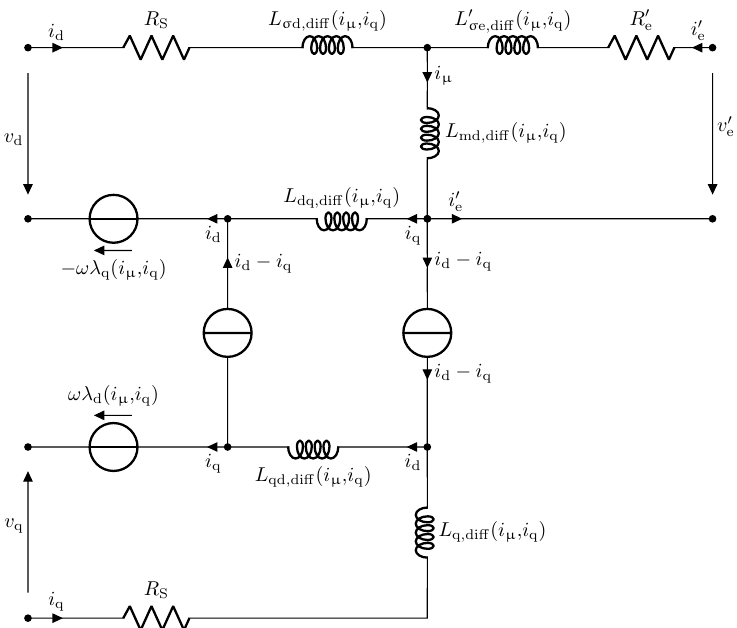
Figure 2. Dynamic equivalent electrical circuit in dq frame for